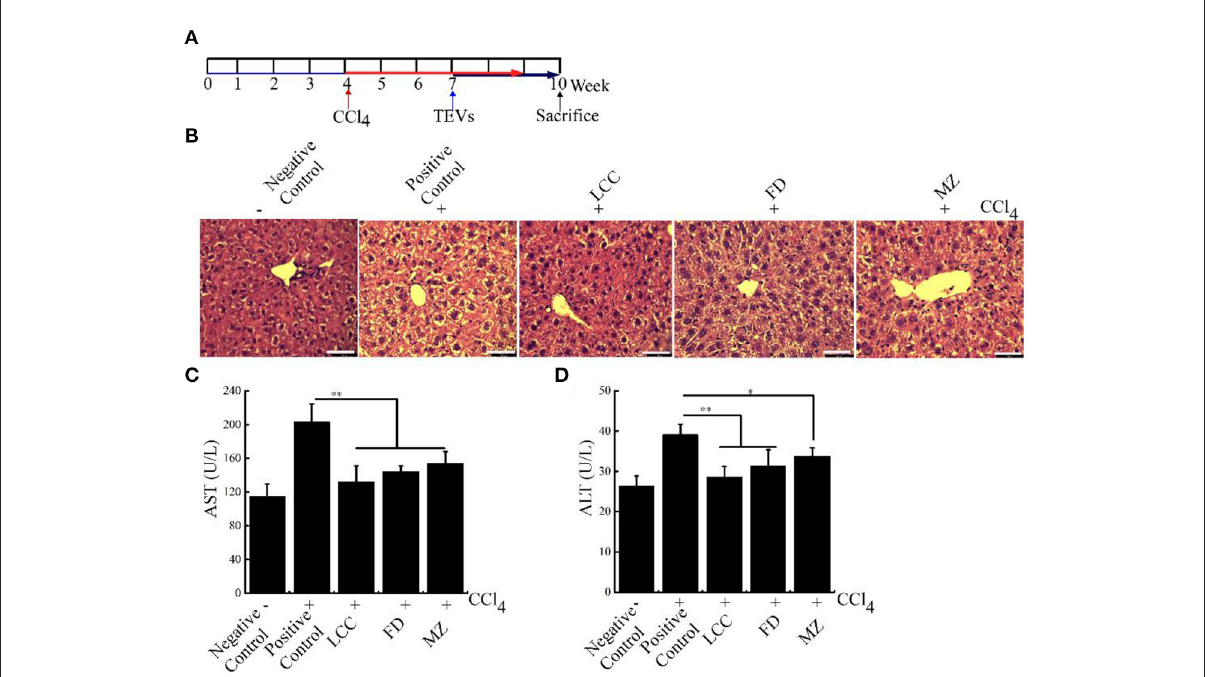
FIGURE5 The effects of TEVs on liver fibrosis in mice. (A) Flow diagram of experimental design employed in these studies. Mice were injected with 1% CCl 4 at a dose of 2 mL/kg for twice times a week. On week 7–10, mice were orally administered with various TEVs (1mg protein/kg mice). (B) H&E staining showed that the fibrogenic changes in mice liver. (C) Determination of the serum AST activity in the different experimental groups. (D) Determination of the serum ALT activity in the different experimental groups. Error bar represents SD ( n = 3; * P < 0.05, ** P < 0.01, indicating significantly different from positive control